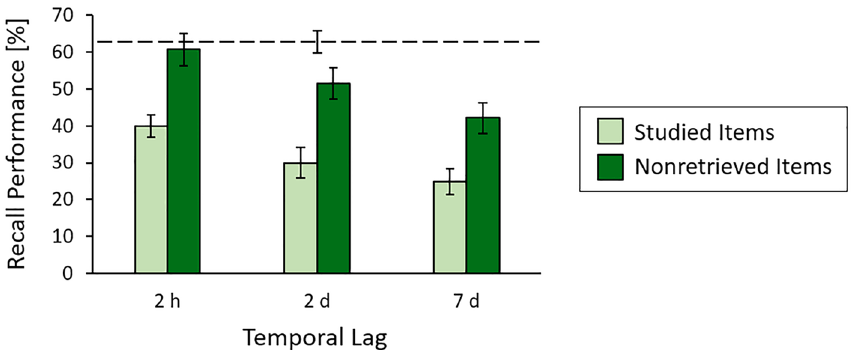
Figure 4. Results of experiment 3. Both recall of the studied items and recall of the nonretrieved items decreased with increasing temporal lag. In all three lag conditions, recall of the nonretrieved items was